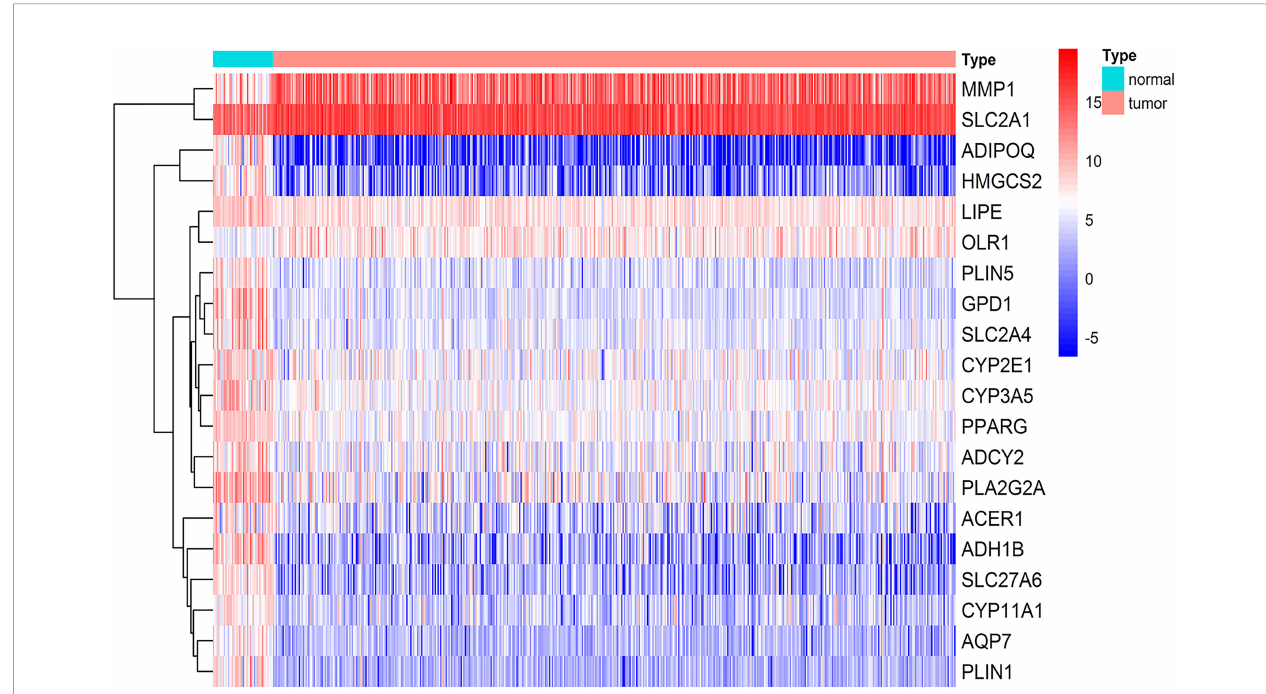
FIGURE 1 | Lipid-related differentially expressed genes (DEGs) in HNSCC. Top 20 of the 65 genes involving lipid metabolism showed abnormal expression in HNSCC from the TCGA database including 44 normal tissues and 502 tumors ( p < 0.01, |logFC| > 2). The color from blue to red represents the gene expressions from high to low between tumors vs. normal